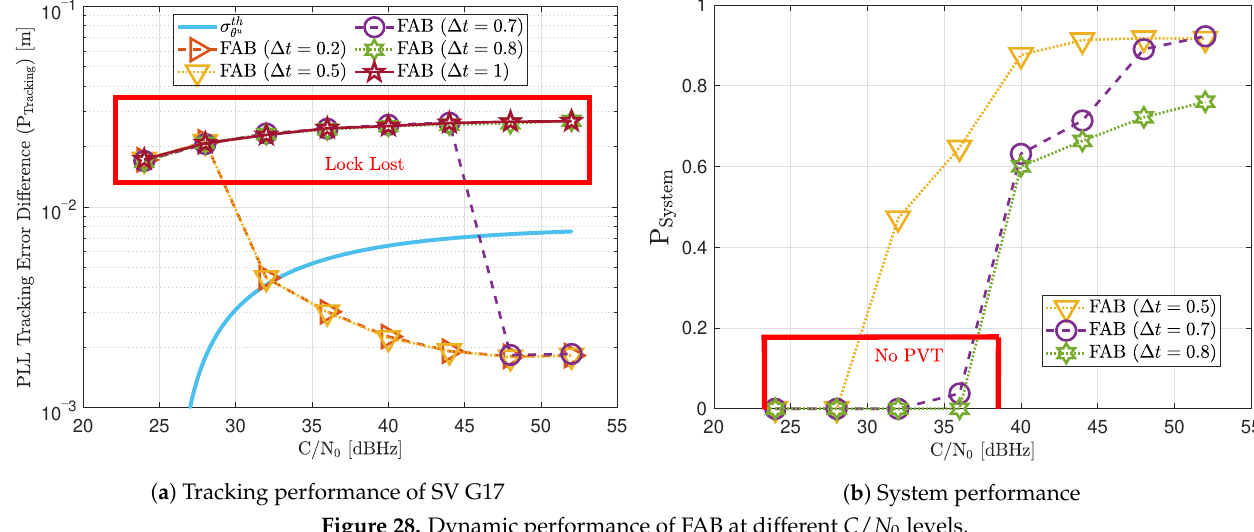
Figure 28. Dynamic performance of FAB at different C / N 0